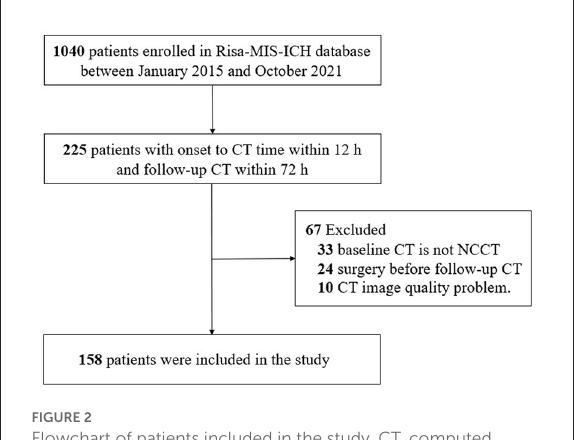
FIGURE2 Flowchart of patients included in the study. CT, computed tomography; NCCT, non-contrast computed tomography; Risa-MIS-ICH, Risk Stratification and Minimally Invasive Surgery in Acute Intracerebral Hemorrhage.